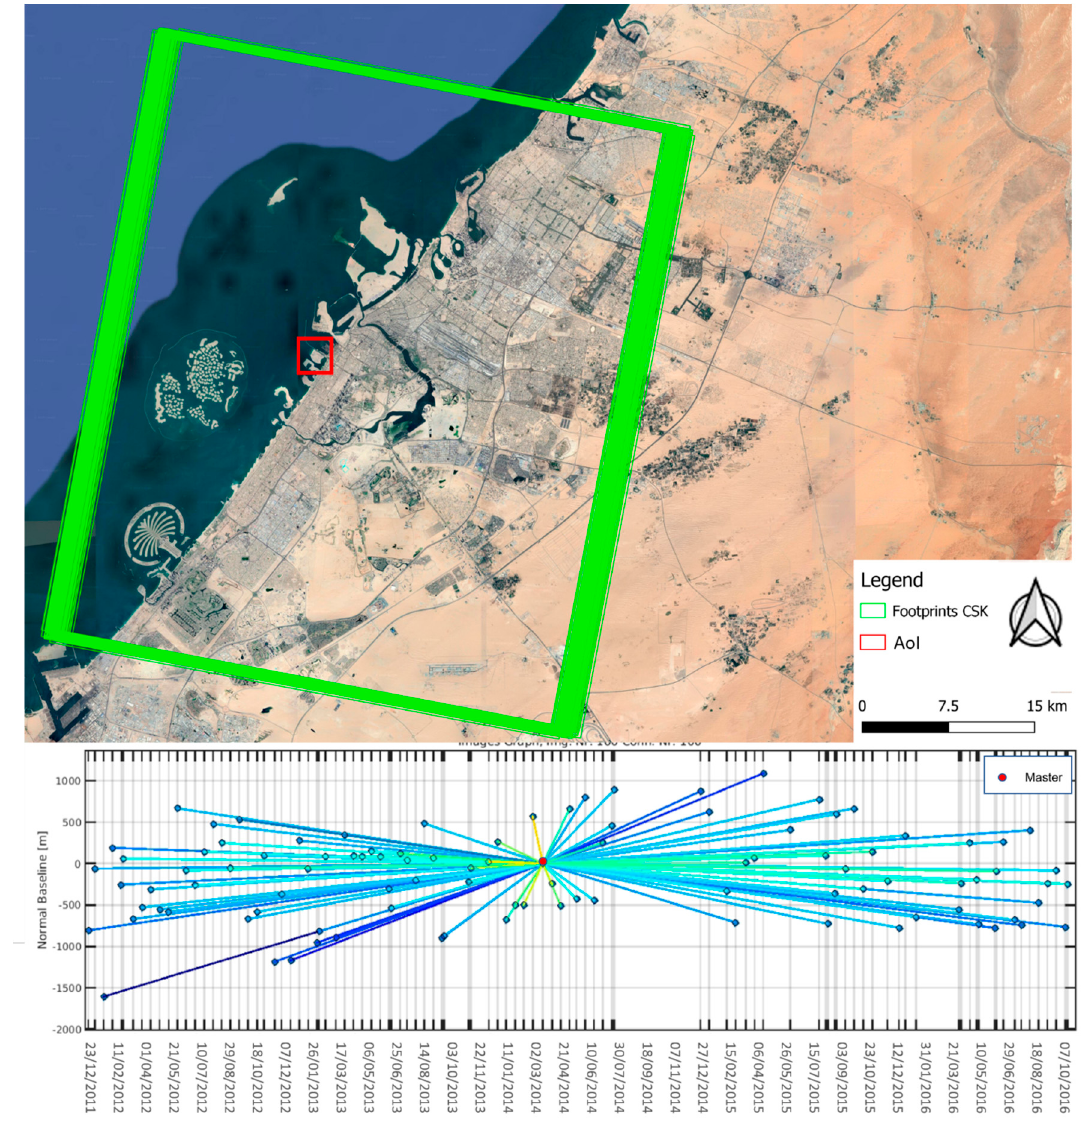
Figure 1. ( Above ) Location of the study area and footprint of COSMO-SkyMed (CSK) images used in this study. ( Below ) Diagram of acquisitions with temporal baseline reported on the x-axis and orbital normal baseline on the y-axis. Each point corresponds to a satellite image; the Master image is reported in red. Project carried out using COSMO-SkyMed ® PRODUCTS, © ASI (Italian Space Agency)—provided under license of ASI.